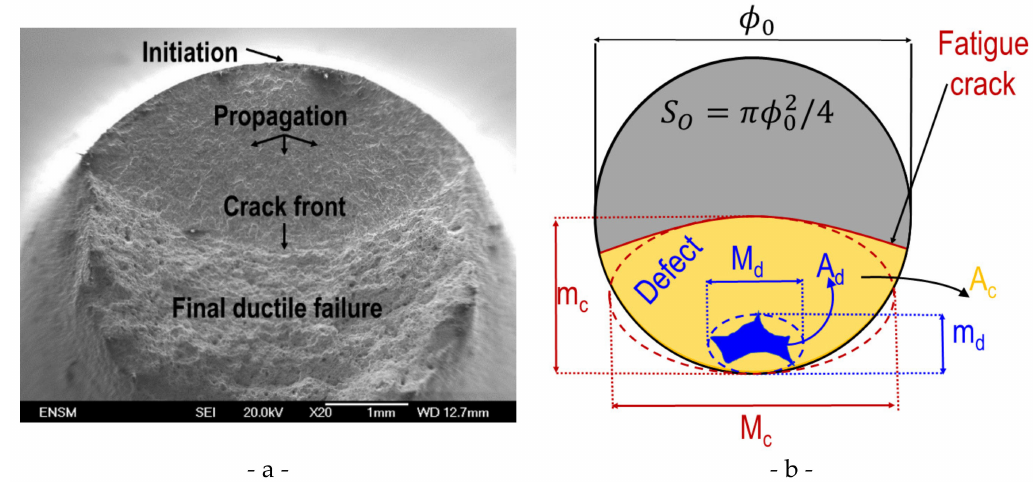
Figure 15. Fracture surface analysis. ( a ) Typical fracture surface with crack initiation at a single defect. ( b ) Different measurements made on each fracture surface to determine the values of the corresponding damage